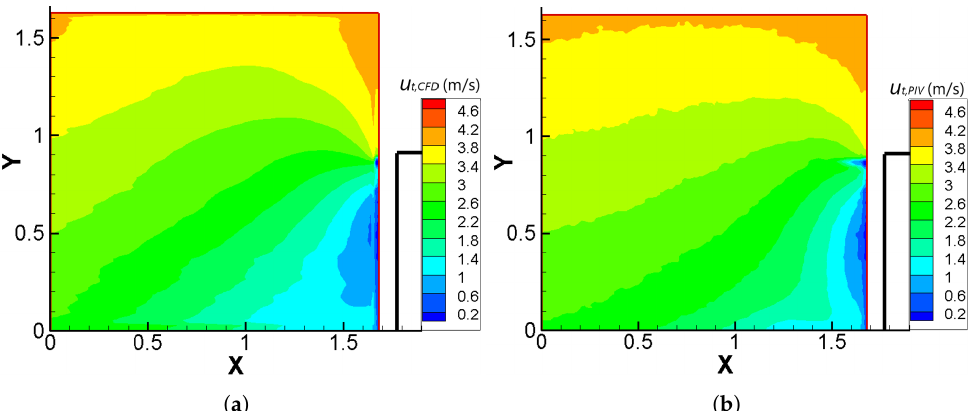
Figure 5. Contours of the total velocities, u t , CFD (m/s) and u t , PIV (m/s), on plane A, extracted by: ( a ) CFD methodology, ( b ) PIV. The solid boundary of the cube is denoted by the thick black line, while X and Y are non-dimensional coordinates. Flow is from left to right.